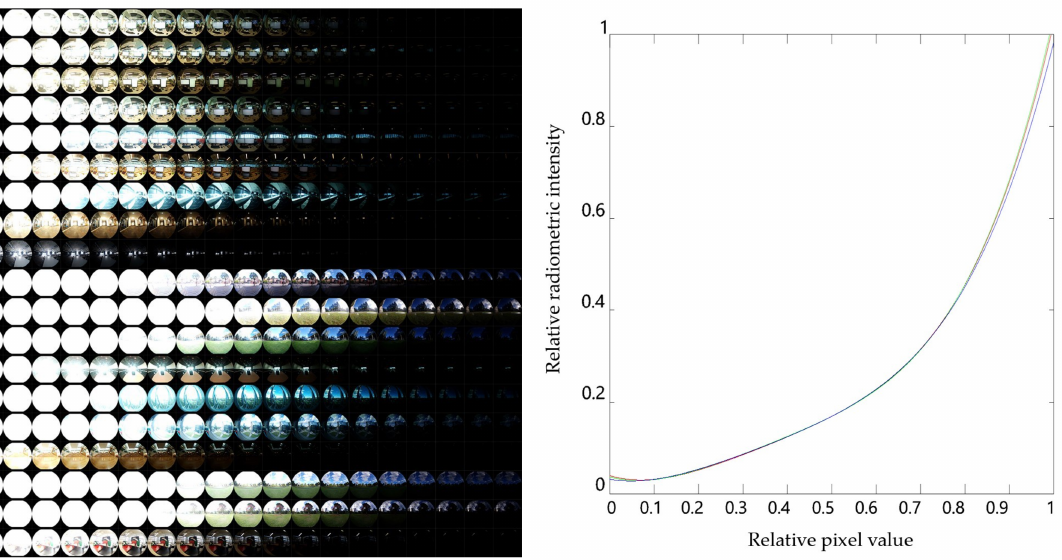
Figure 13. Show matrix of LDR images used for computing CRF for HDR images on the left and the CFR computed in MATLAB on the